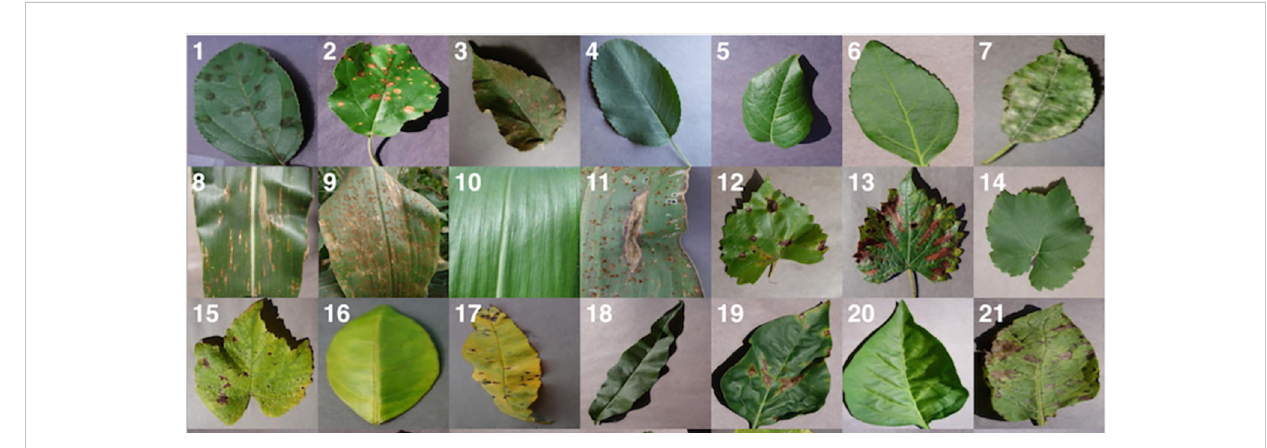
FIGURE 5 Some random images from plantvillage dataset (Hughes and Salathe ́ ,